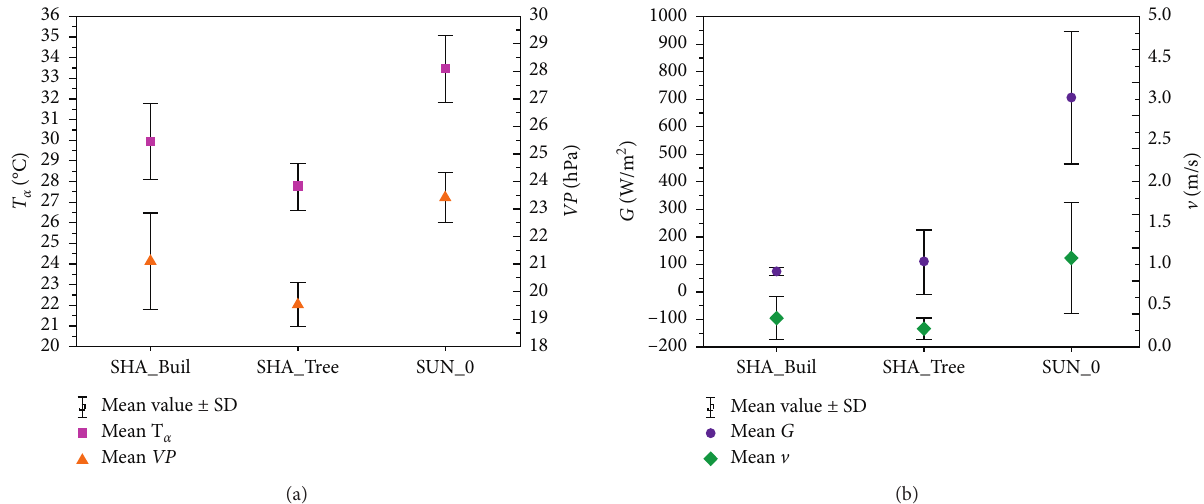
Figure 2: Statistical distribution of micrometeorological parameters at the research sites: (a) T